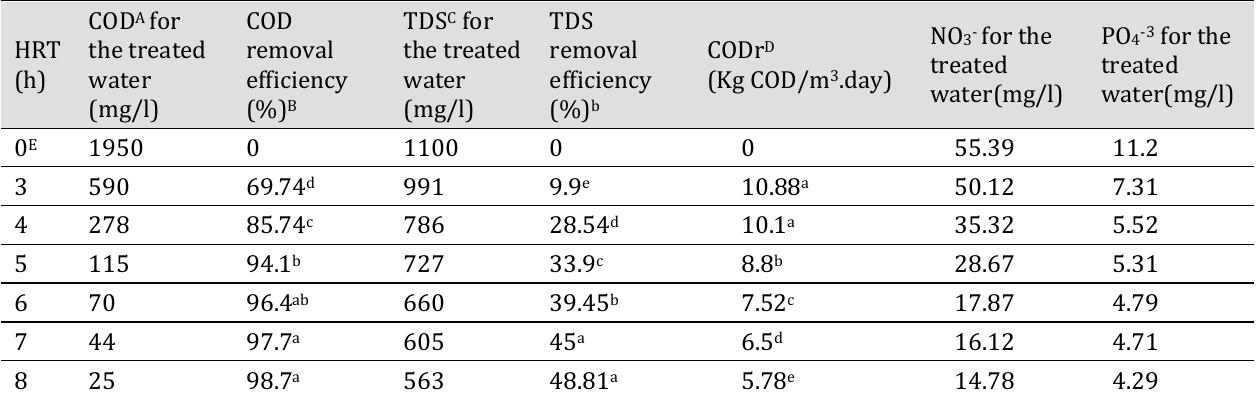
Table 4. MBBR system monitoring for different hydraulic retention time (HRT) periods and different biochemical indices